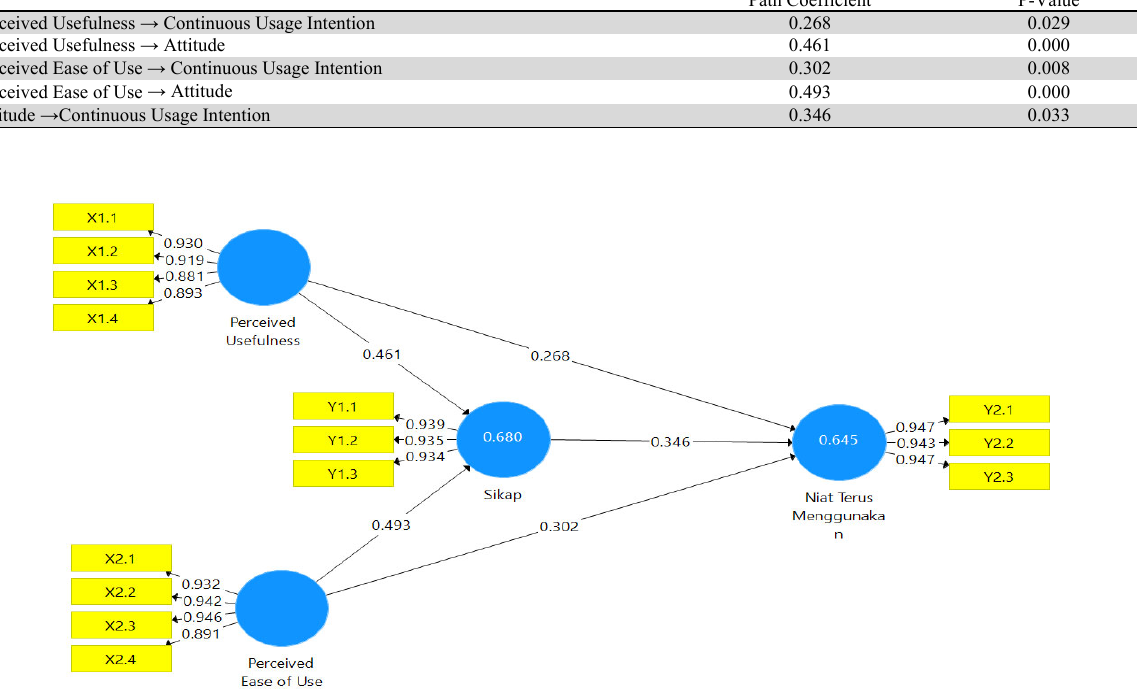
Fig. 2. The results of structural equation